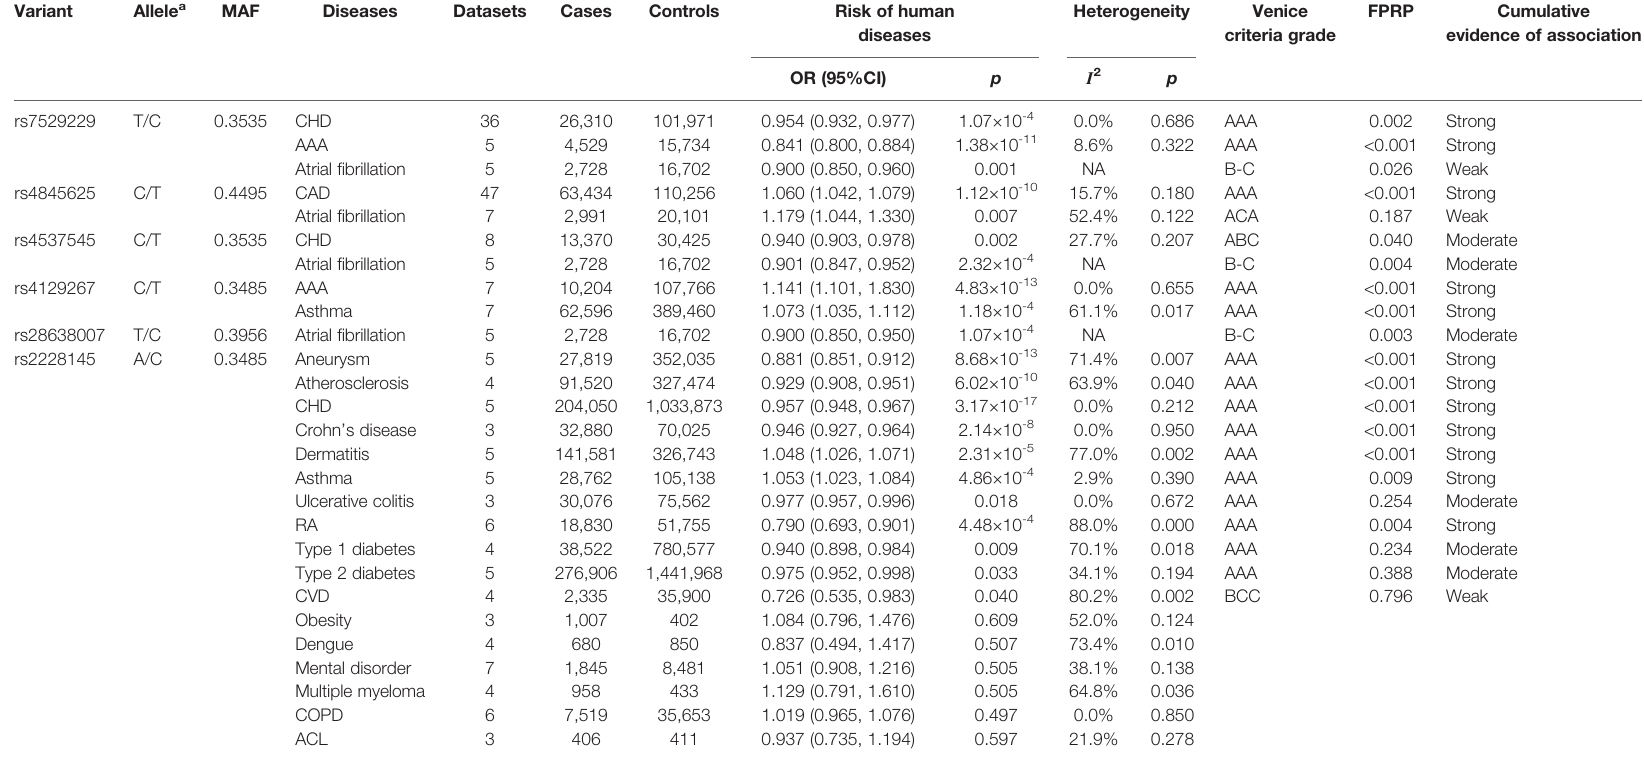
TABLE 1 | Variants in the IL6R gene associated with risk of human diseases in